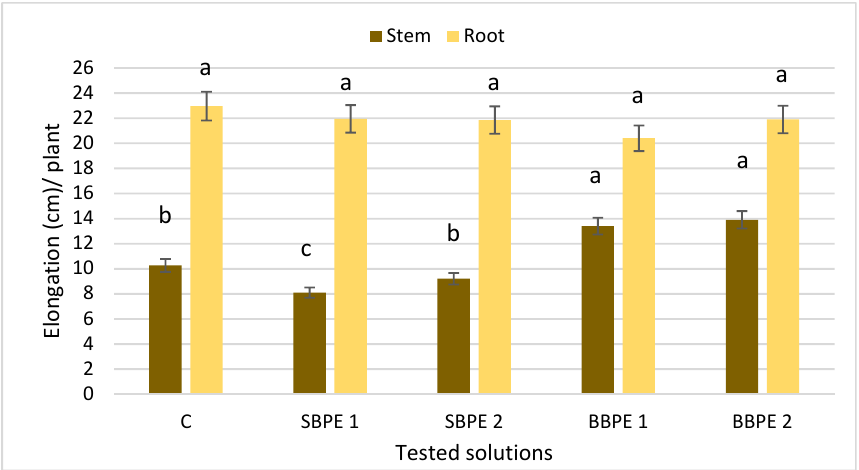
Figure 3. Influence of bark extracts on vegetative organ elongation in lemon balm. Bars show that the same letter is not significantly different at p ≤ 0.05. Error bars represent the standard deviation of means. C—control. SBPE 1—spruce bark polyphenolic extract at a concentration of 0.25 g bark/100 mL water. SBPE 2—spruce bark polyphenolic extract at a concentration of 0.5 g bark/100 mL water. BBPE 1—beech bark polyphenolic extract at a concentration of 0.25 g bark/100 mL water. BBPE 2—beech bark polyphenolic extract at a concentration of 0.5 g bark/100 mL water.